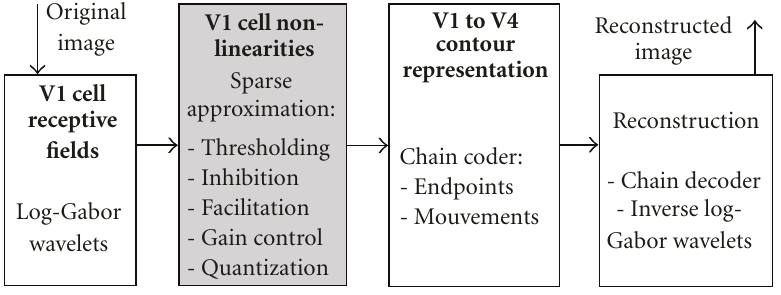
Figure 1: Scheme of the algorithm. The lossy parts, that is, the operations inducing information losses, are depicted with gray color.